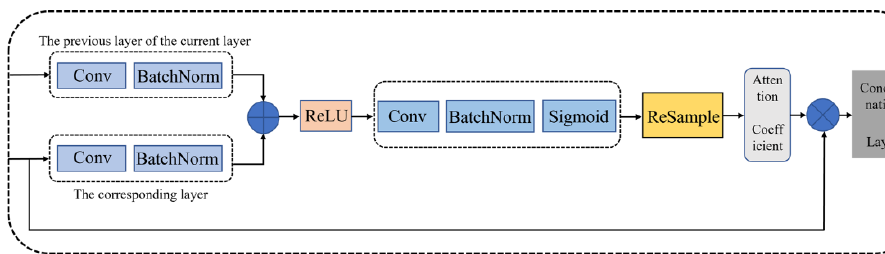
Figure 4. The architecture of the RIAU-Net model.